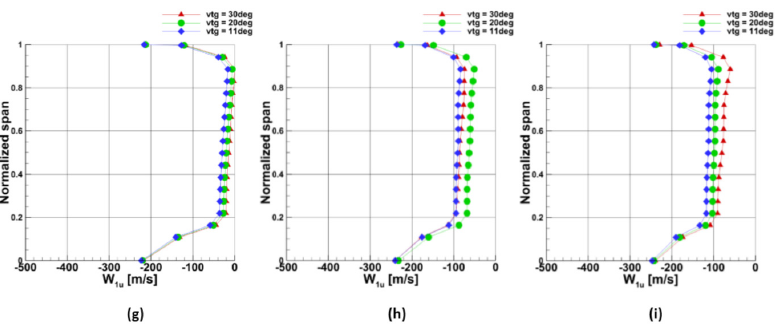
Figure 29. The plots of the tangential component of the relative velocity W 1 u measured behind the 1st stage nozzle vane against the blade height for: ( a – c ) 60,000 rpm point A, B, C respectively, ( d – f )